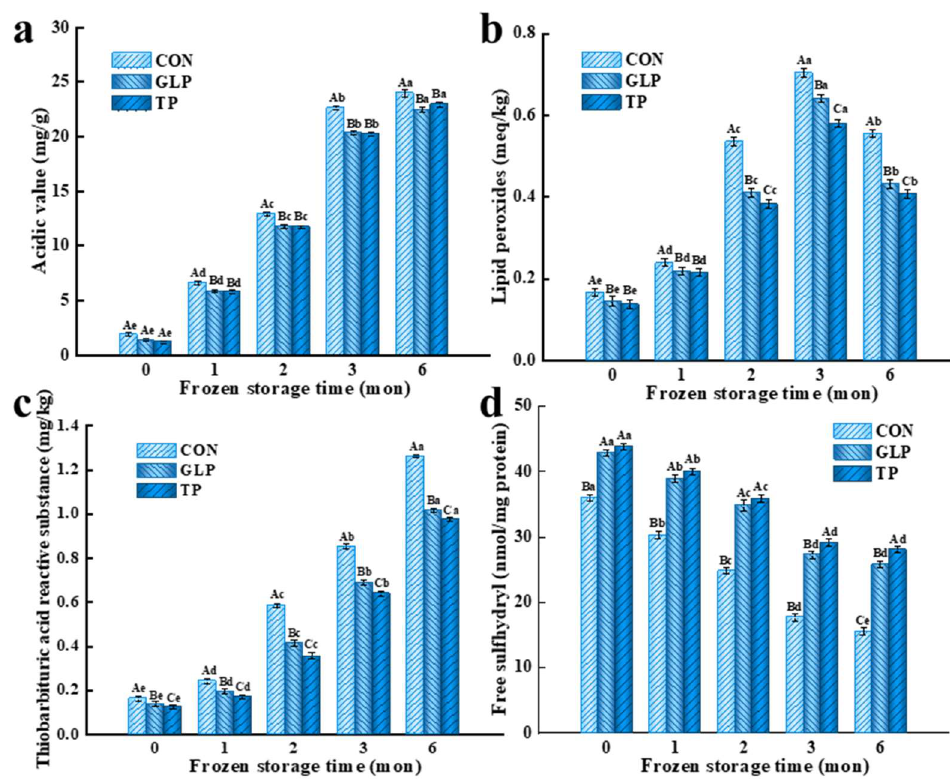
Figure 1. Effect of guava leaf polyphenols on the oxidation stability of frozen chicken meatballs. ( a ), Acidic value; ( b ), Lipid peroxides; ( c ), Thiobarbituric acid reactive substances; ( d ), Free sulfhydryl. GLP, guava leaf polyphenols; TP, tea polyphenol; CON, control. The means at the same frozen storage with different uppercase letters (A–C) differ significantly ( p < 0.05); the means at the same polyphenol processing with different lowercase letters (a–e) differ significantly ( p < 0.05). The results are mean ± SE ( n = 3).